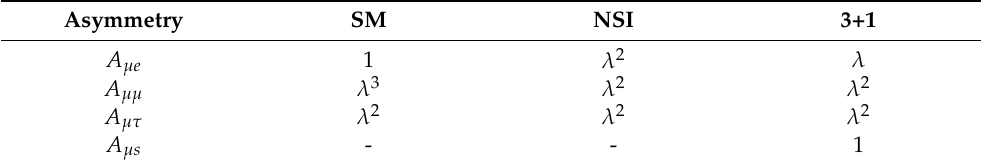
Table 1. Order of magnitude estimates of the various contributions to the asymmetries discussed in this paper. λ is a common order parameter such that: r , s , a , ∆ 21 , V CC , ε αβ , θ i 4 ∼ O ( λ ) . Asymmetry SM NSI 3+1 A µ e 1 λ 2 λ A µµ λ 3 λ 2 λ 2 A µτ λ 2 λ 2 λ 2 A µ s - -